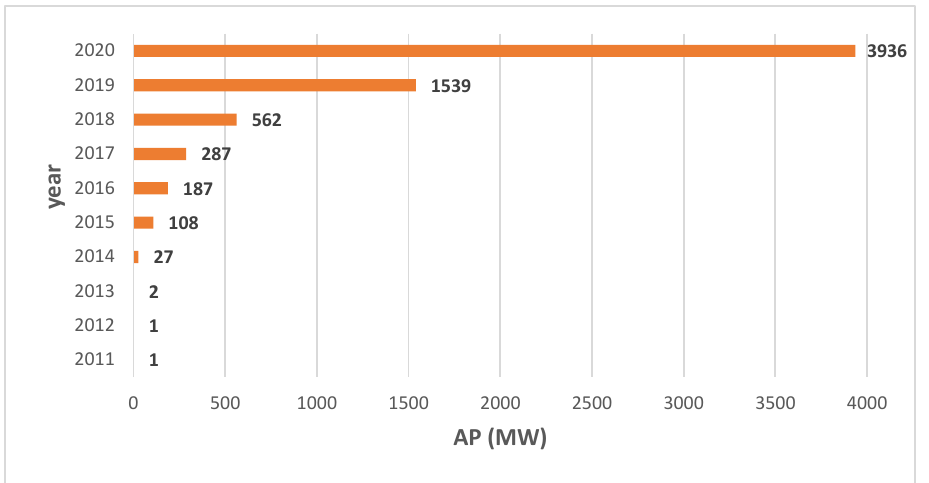
Figure 3. The solar photovoltaic capacity installed and connected at the end of the calendar year 2020 in Poland (MW). Source: Renewable capacity statistics 2021, www.irena.org/Statistics/ (accessed on 22 March 2021) [57].